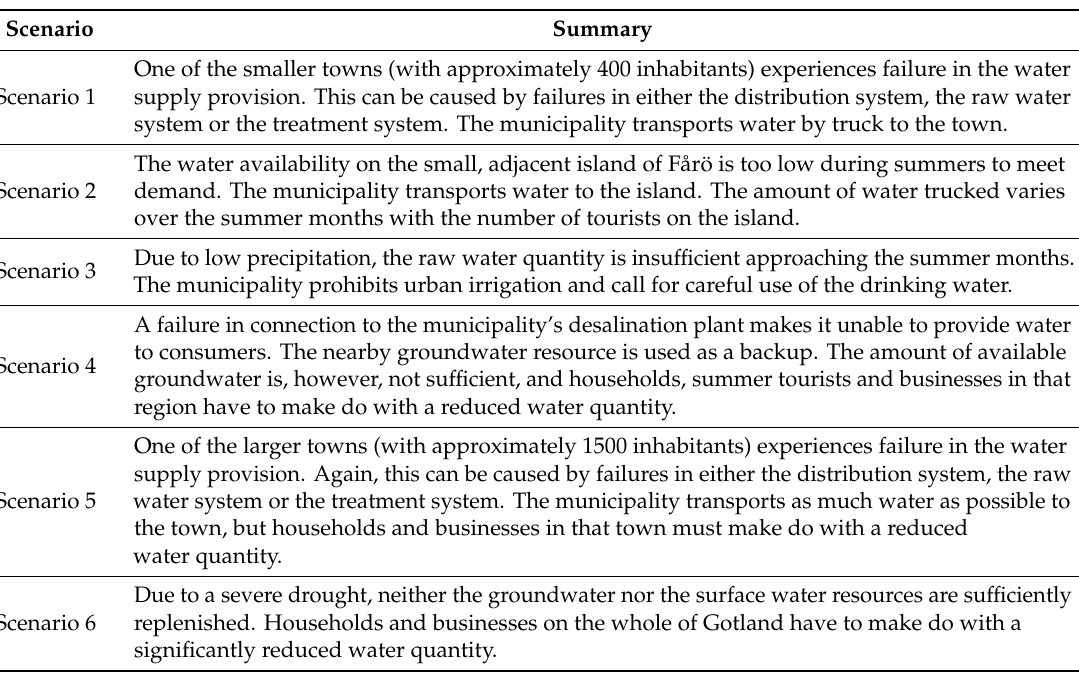
Table 1. Scenario summaries.